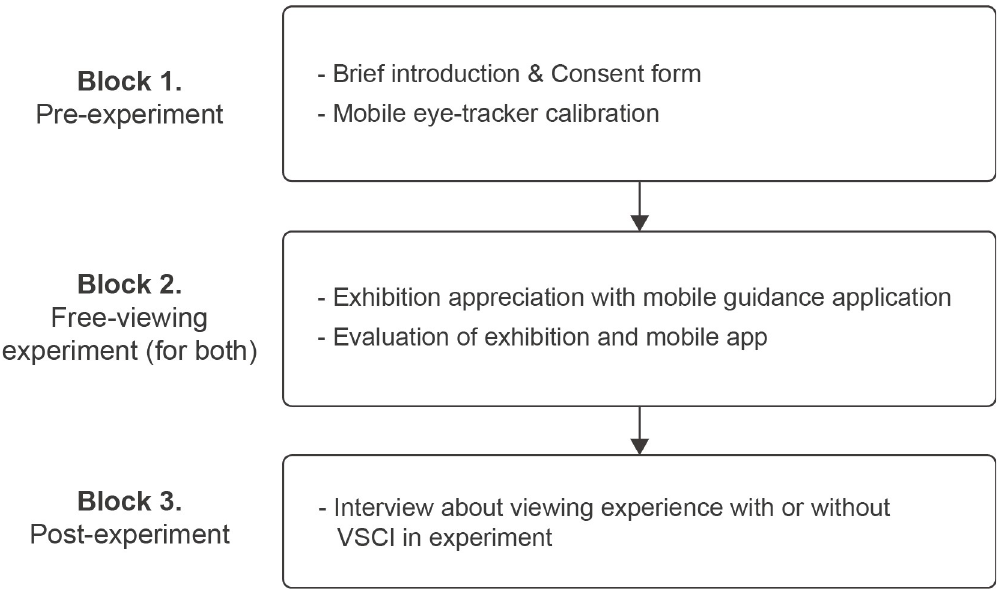
Fig 4. Experimental process for the three blocks. VSCI represents “visitor-based social contextual information”.